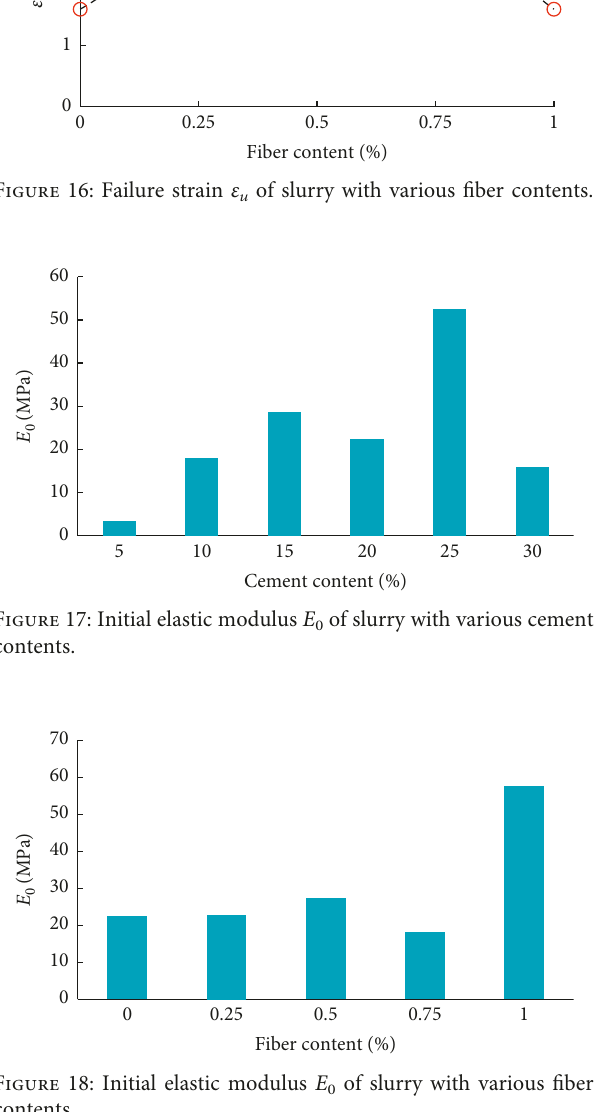
0 of slurry with various fiber